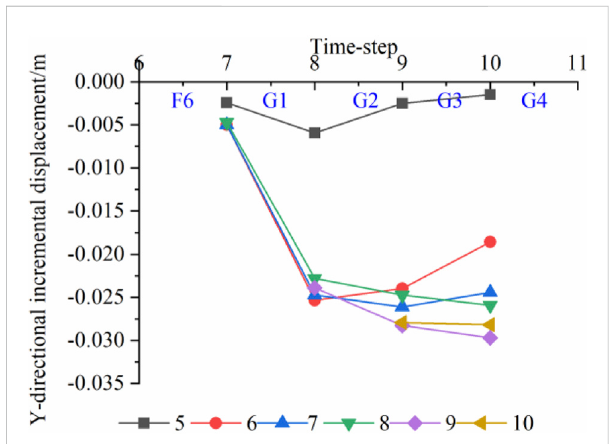
FIGURE 11 Y-directional incremental displacements of monitor points during the G area fi lling process.